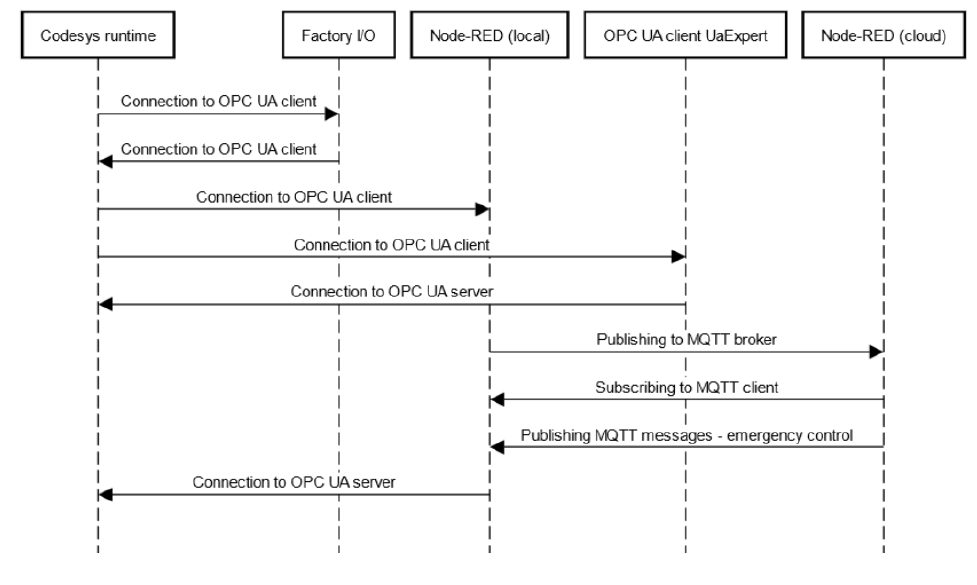
Figure 18. Sequence diagram for second case